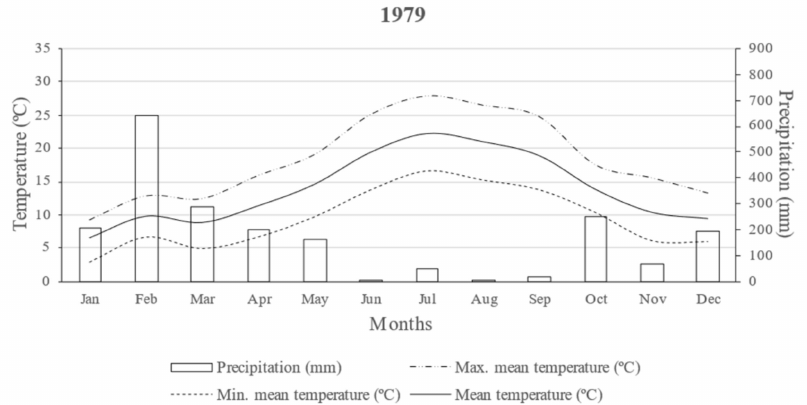
Figure 2. Distribution of climatic parameters for the year